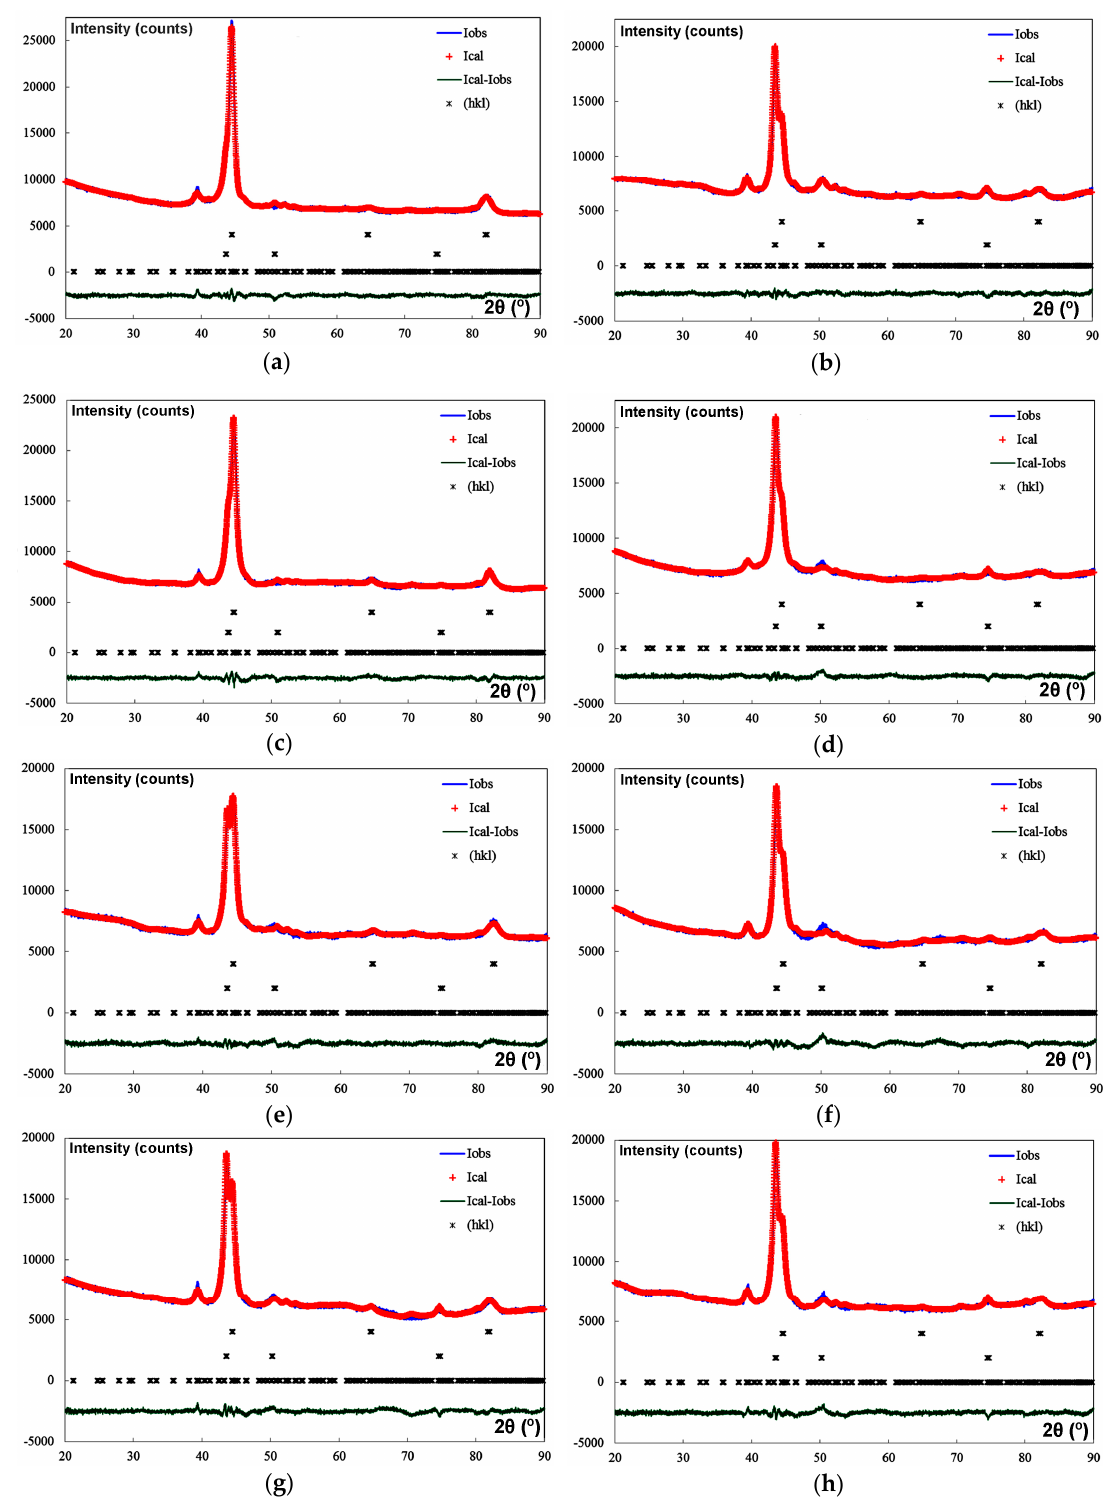
Figure 3. Overall fittings obtained by means of Rietveld structural refinement. The blue plots